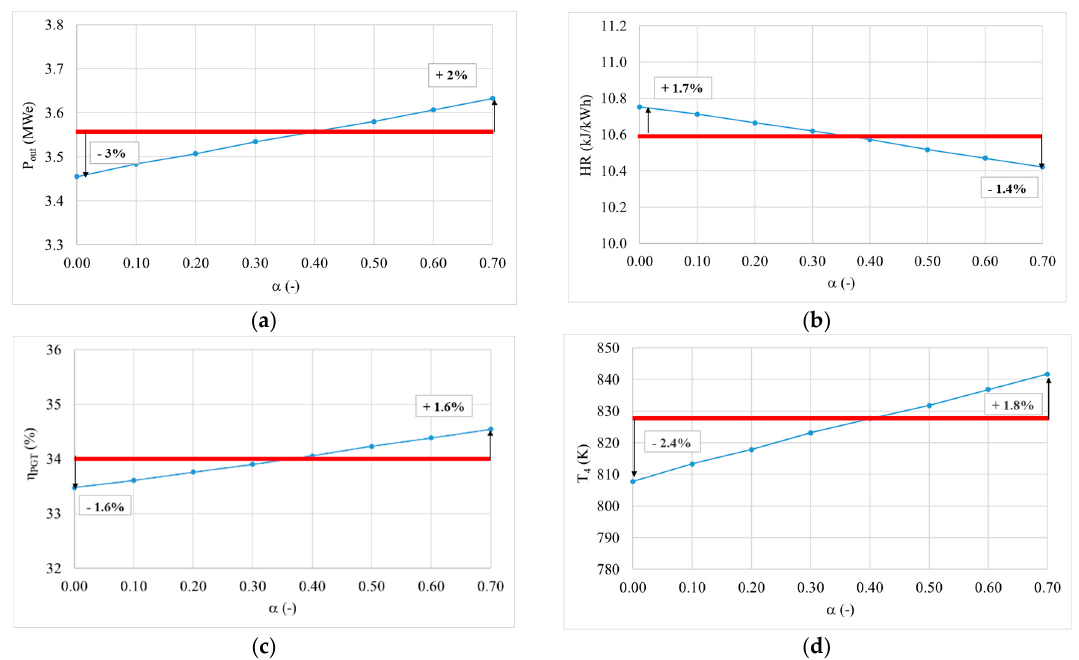
Figure 10. Change of gas turbine cycle outlet parameters in function of steam/fuel ratio ( a ) power change in function of steam/fuel ratio, ( b ) heat rate change in function of steam/fuel ratio, ( c ) gas turbine plant efficiency change in function of steam/fuel ratio and ( d ) change of temperature of the expanded products at the gas turbine outlet in function of steam/fuel ratio.